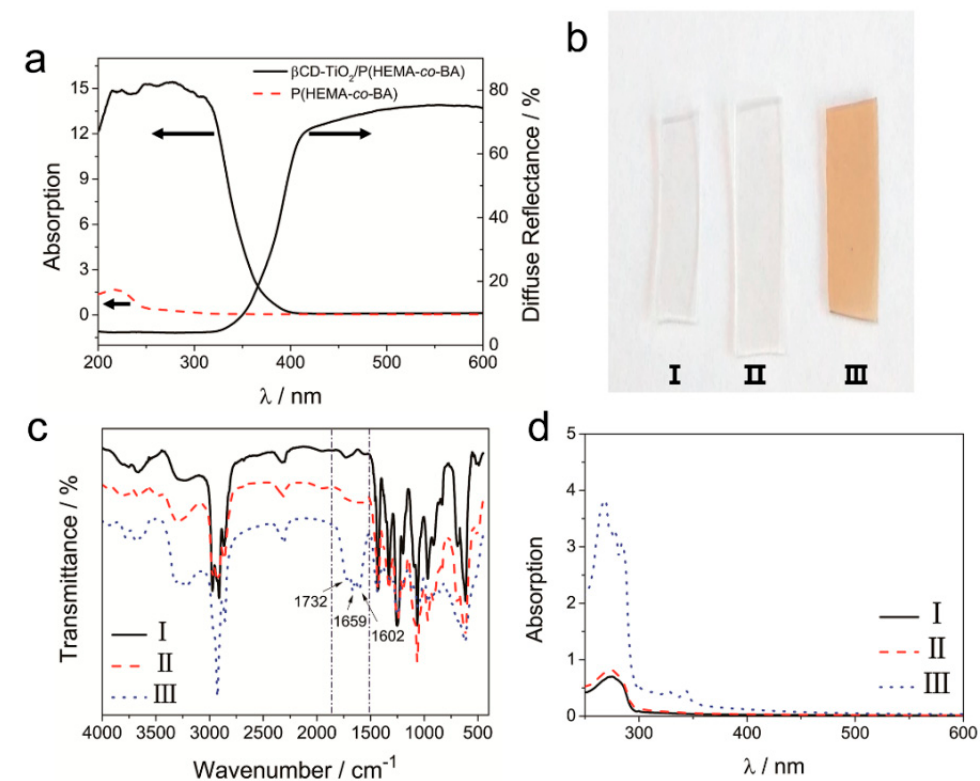
Figure 11. UV-shielding properties of the β -CD-TiO 2 / P(HEMA-co-BA) coating: ( a ) UV-Vis absorption and diffuse reflectance spectroscopy; ( b ) photographs of three sample strips; ( c ) FT-IR spectra of three samples; ( d ) UV-Vis absorption spectra of three samples (I: PVC initial sample; II: PVC sample subjected to UV-vis accelerated aging with coating; III: PVC sample subjected to UV-vis accelerated aging without coating).